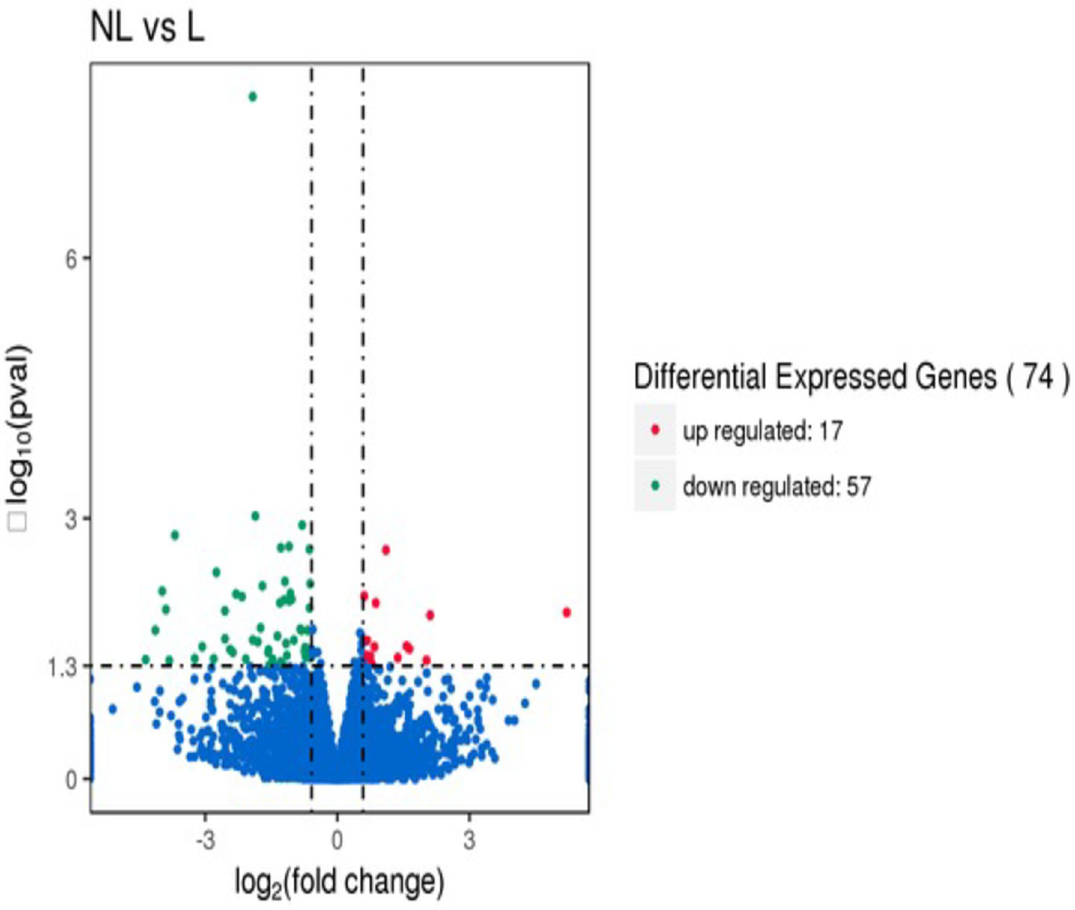
Fig 3. Volcano plot for (DEGs) differentially expressed genes between learner and failed-learner groups.